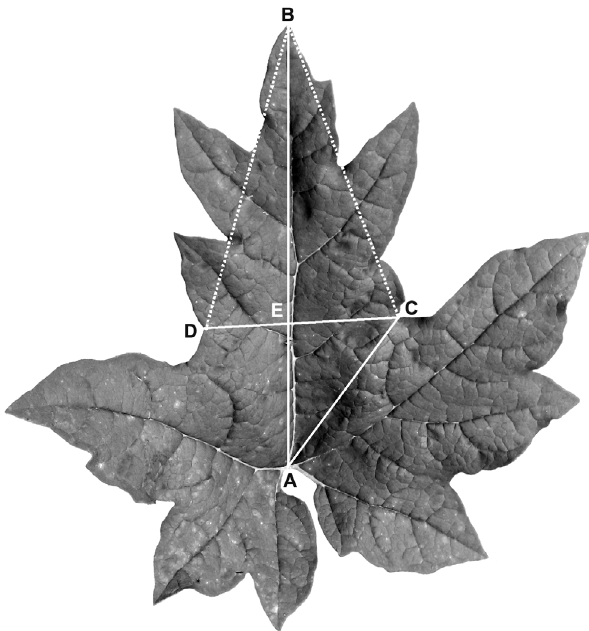
Figure 2. The measurement of a leaf blade of Rheumpalmatum complex. A typical leaf form of No. 5 individual of